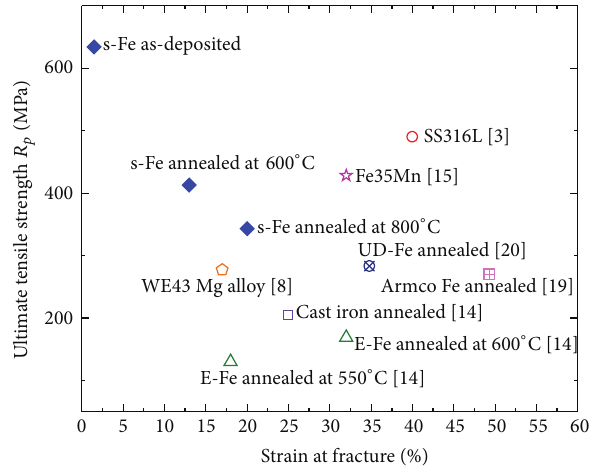
Figure8:Overviewofthemechanicalpropertiesfoundinthisstudy for different annealed samples (as-deposited, 600 ∘ C, 2h, and 800 ∘ C, 2 h) compared to literature values for biodegradable materials.